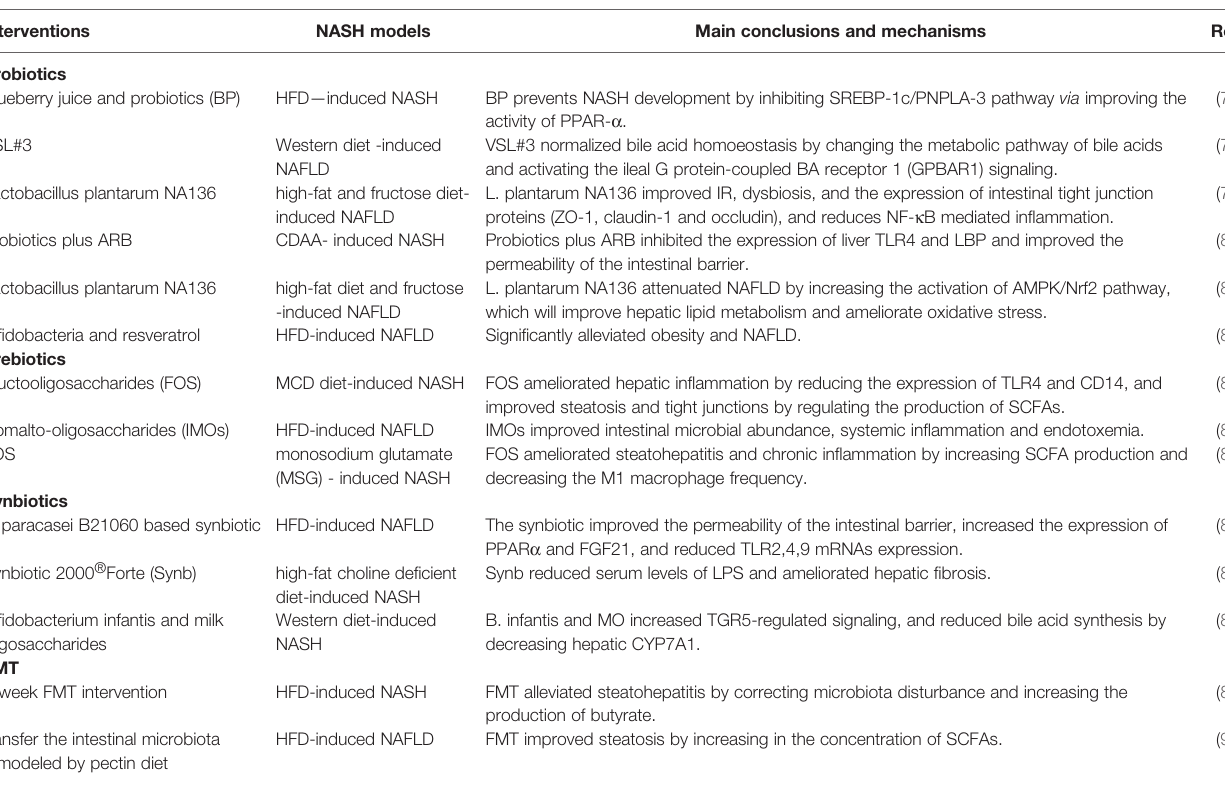
TABLE 3 | Intestinal microbiota-targeted therapies of NASH-animal